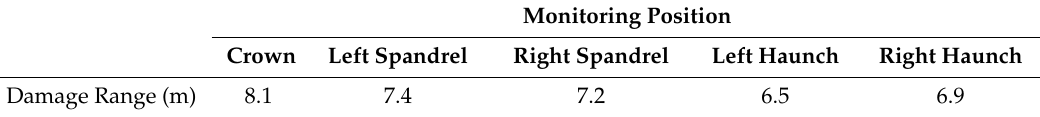
Figure 14. Curves of the displacement at the special time points vs. depth. Table 6. Damage range of the surrounding rock at different positions.